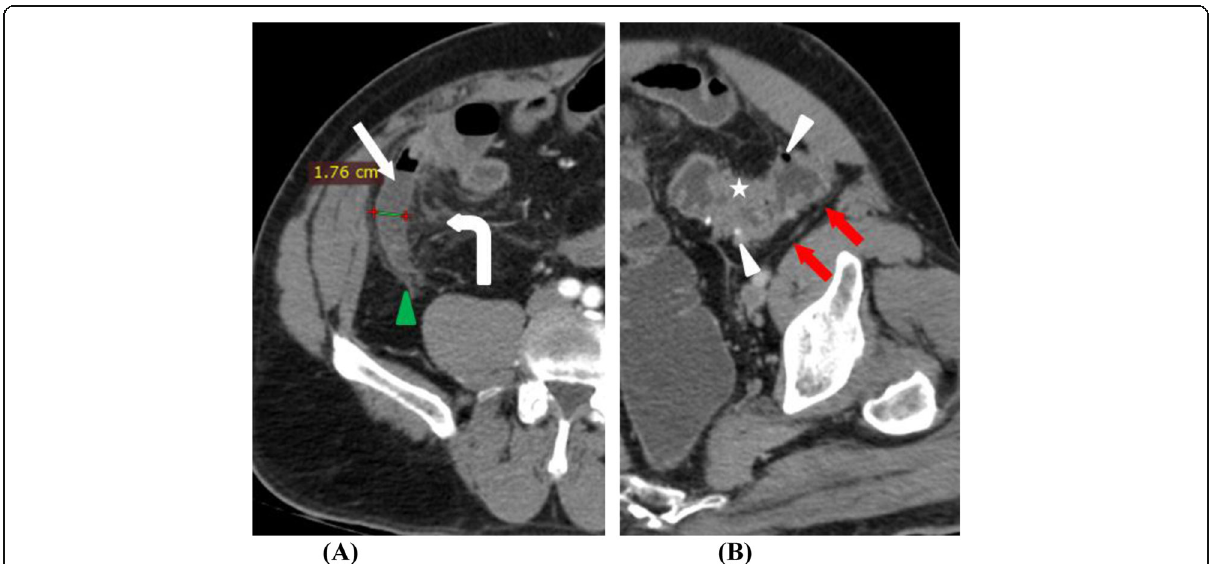
Fig. 10 Acute appendicitis and acute divertculitis in a 68-year-old male patient presented with acute lower abdominal pain. a , b Focused axial CT images following water enema and intravenous contrast injection. a Showing dilated appendix (white arrow) with related extensive fat stranding